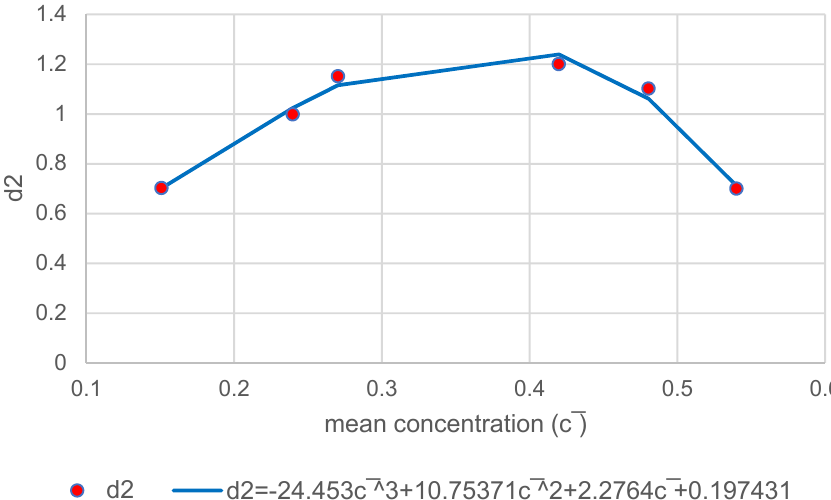
Figure 16. Mean concentration vs. coefficient d 2 using KNN ( R 2 = 0.979 ).